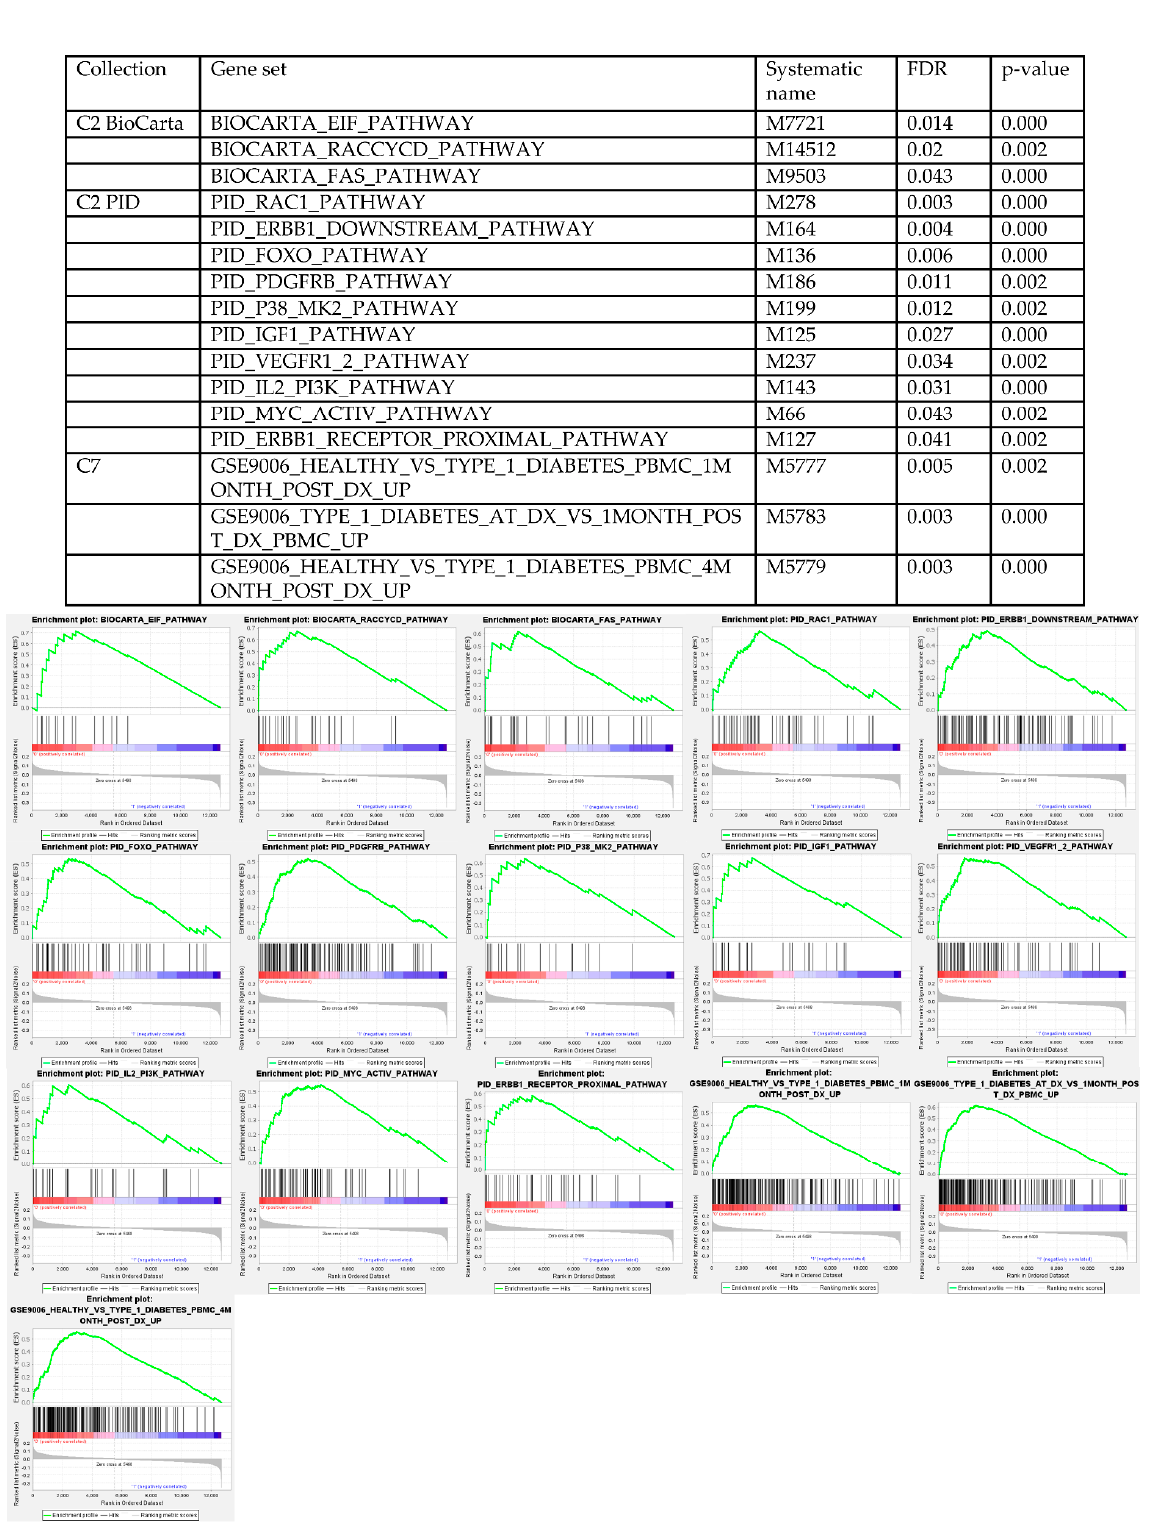
Figure 6. Gene Set Enrichment Analysis (GSEA) results. Table shows the gene sets found to be enriched in the low vs. high SRY expression group, with the FDR < 0.05 and p -value < 0.05. Enrichment plots are then presented for each of the sets.